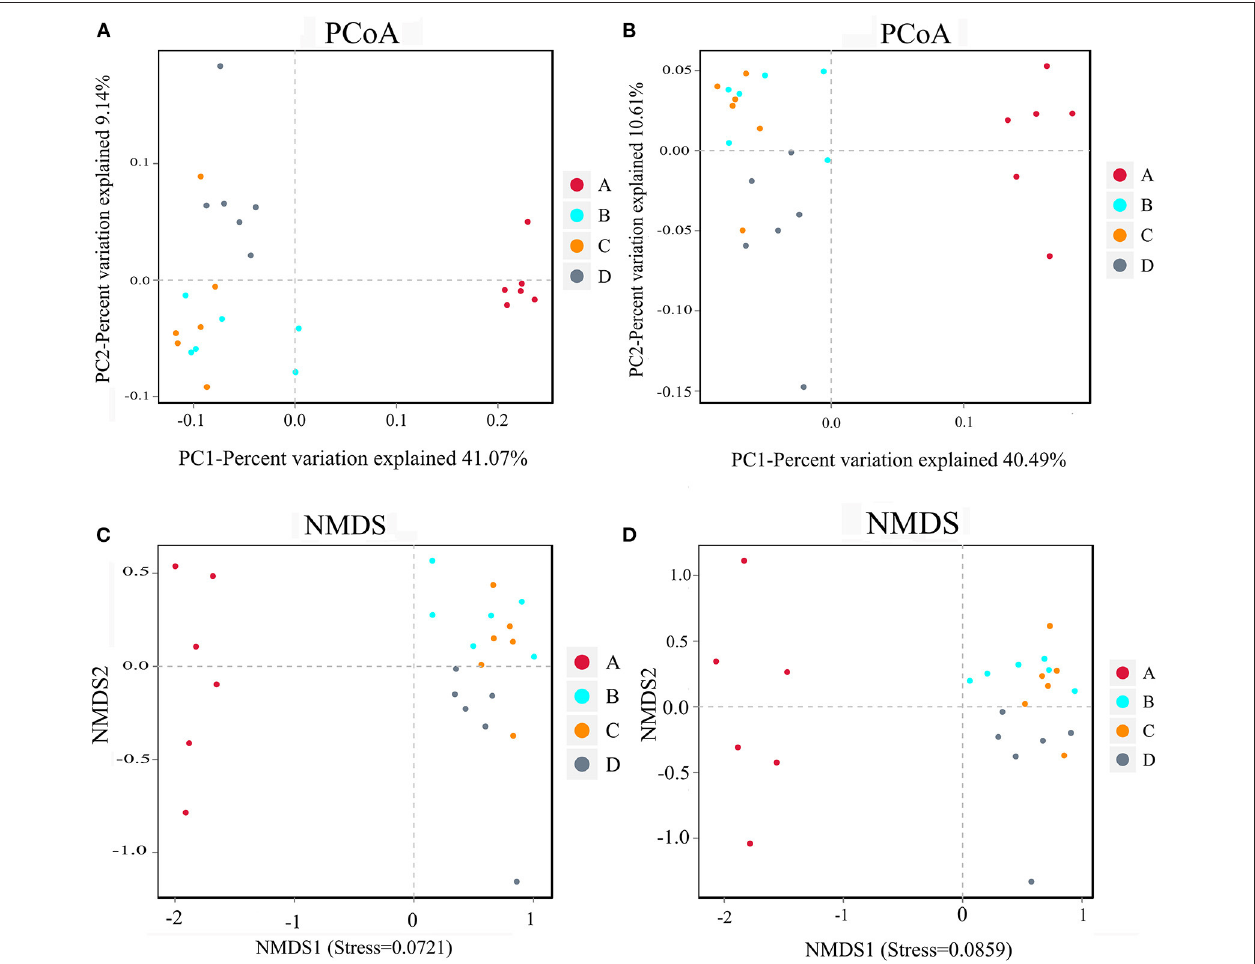
FIGURE 3 | PCoA analysis chart and NMDS analysis chart of the bacteria in mouse feces. (A,C) Binary jaccard; (B,D) unweighted unifrac. A: NT-free group; B: basal diet group; C: NT intervention group; D: model control